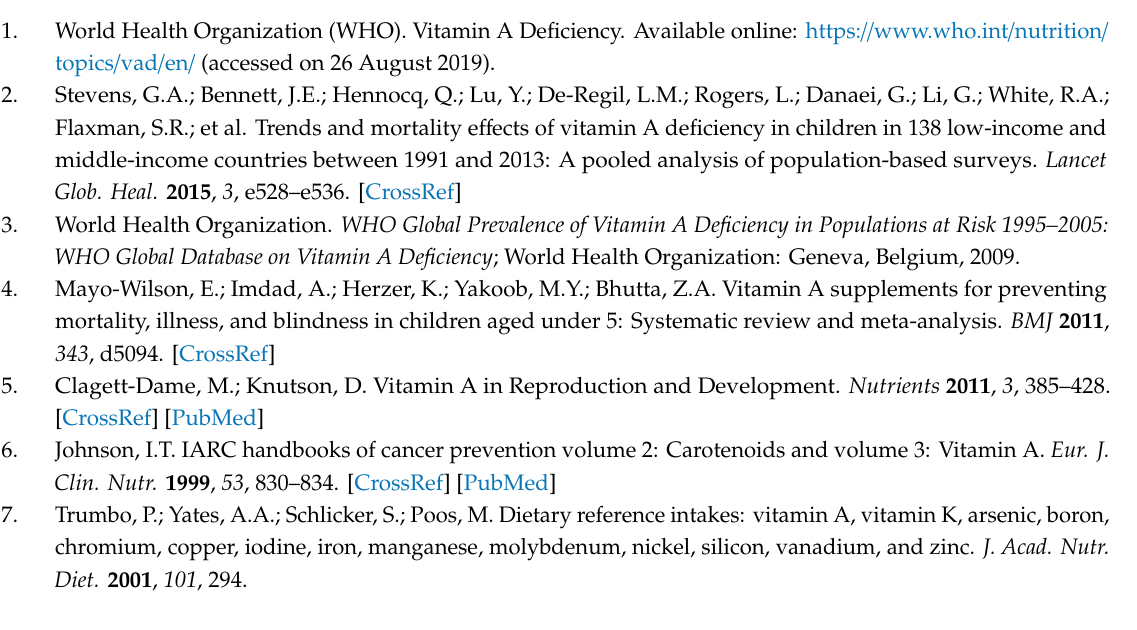
Figure S1: Spearman correlation of plasma carotenoid and retinol concentrations [ µ mol / L] with calculated intake [g / d] per food group; Table S1: Concentrations of retinol, α -carotene, β -carotene, β -cryptoxanthin, lutein, lycopene and zeaxanthin analyzed in Standard Reference Material ® 968d provided by the National Institute of Standards and Technology (NIST); Table S2: Concentrations of plasma total carotenoids, provitamin A and retinol, and vitamin A deficiency across genotypes of the variants in the BCO1 gene; Table S3: Plasma concentrations of provitamin A carotenoids across genotypes of the variants in the BCO1 gene; Table S4: Plasma concentrations of non-provitamin A carotenoids across genotypes of the variants in the BCO1